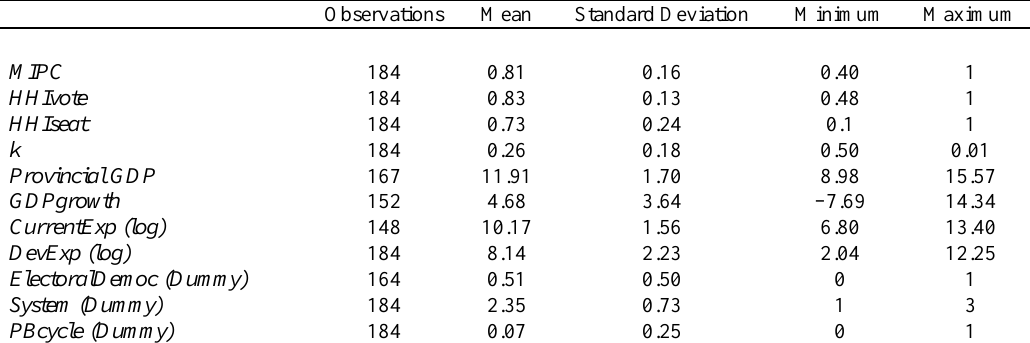
Table 1a: Summary Statistics: Subnational level